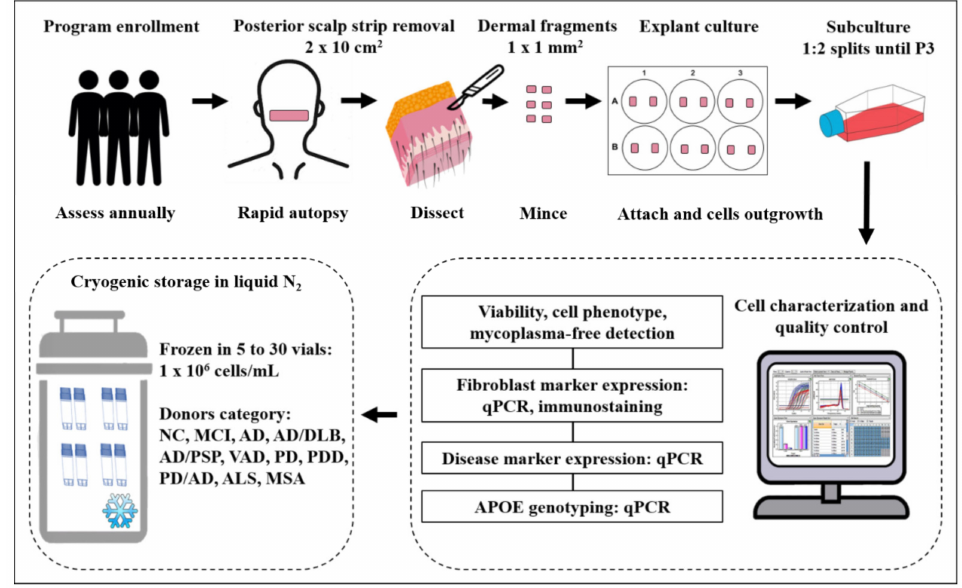
Figure 1. The workflow established in this study for postmortem human fibroblast banking at the Brain and Body Donation Program of Banner Sun Health Research